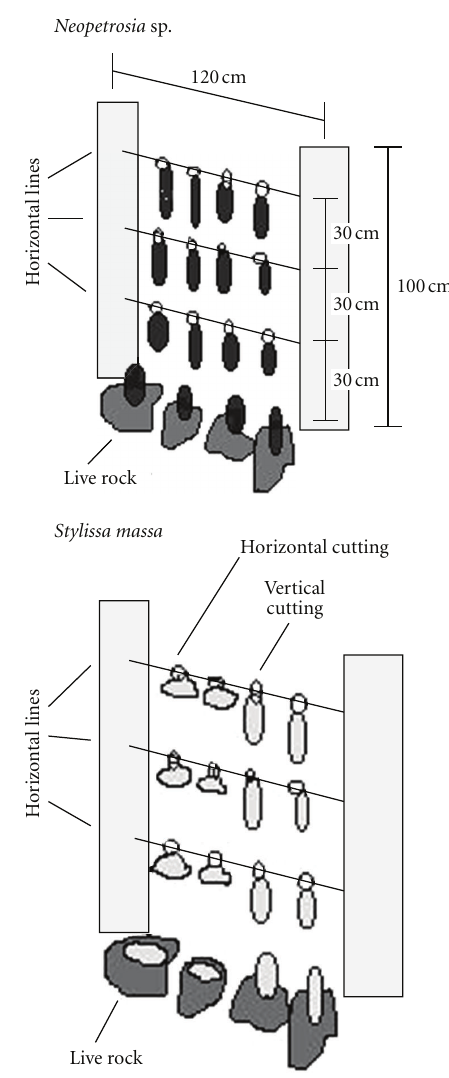
Figure 4: A scheme of Neopetrosia sp . (top) and S. massa (down) fragments on horizontal lines and live rock at the field sites.